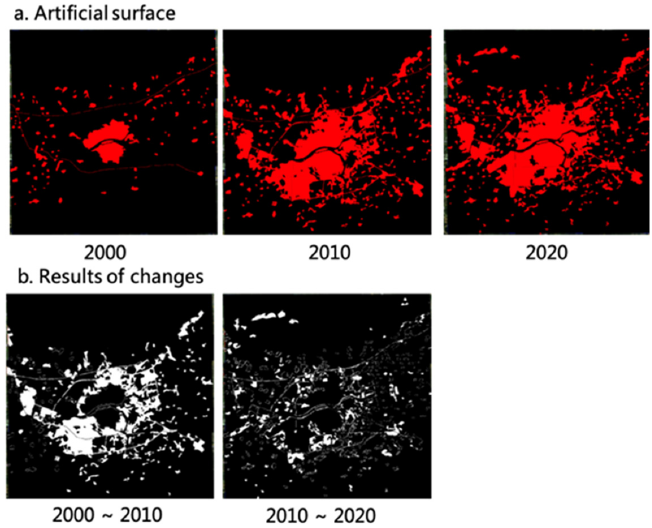
Figure 13. Artificial land cover change detection results.